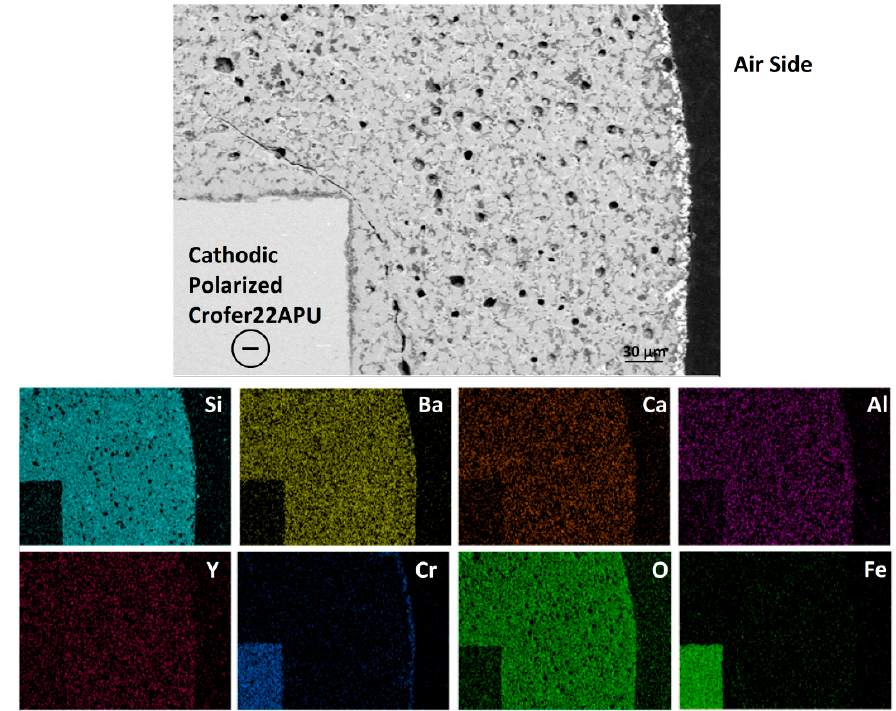
Figure 6. SEM-EDS post mortem analysis at cathodic polarized Crofer22APU / HJ28 glass-ceramic Figure 6. SEM ‐ EDS post mortem analysis at cathodic polarized Crofer22APU/HJ28 glass ‐ ceramic interface after the dual test, collected at air interface after the dual test, collected at air side.